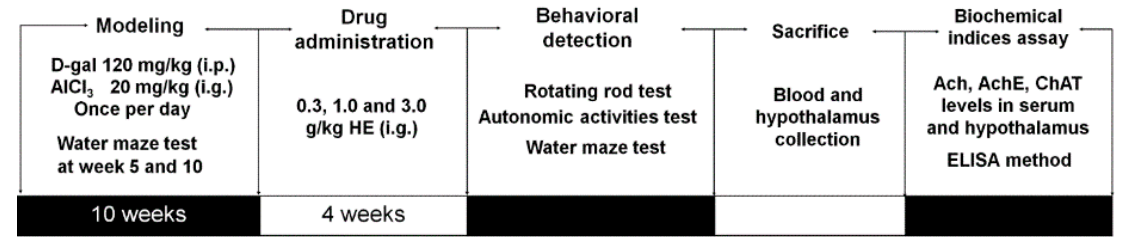
Figure 6. The experimental protocol for AlCl 3 - and D -gal-induced Alzheimer’s disease mouse model establishment and drug administration.